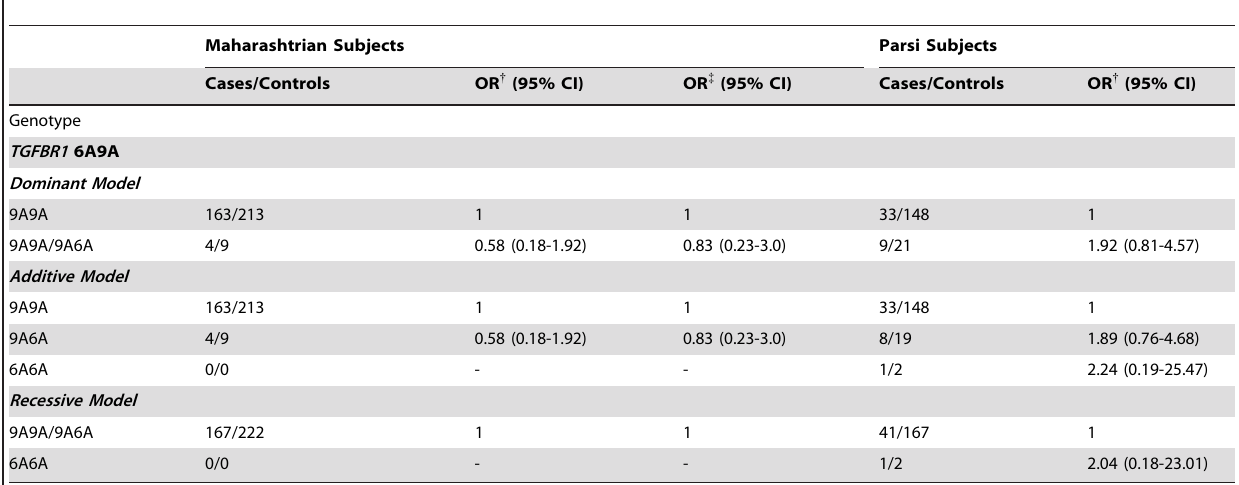
Table 5. TGFBR1 6A/9A polymorphism and risk for breast cancer in Maharashtrian and Parsi women.